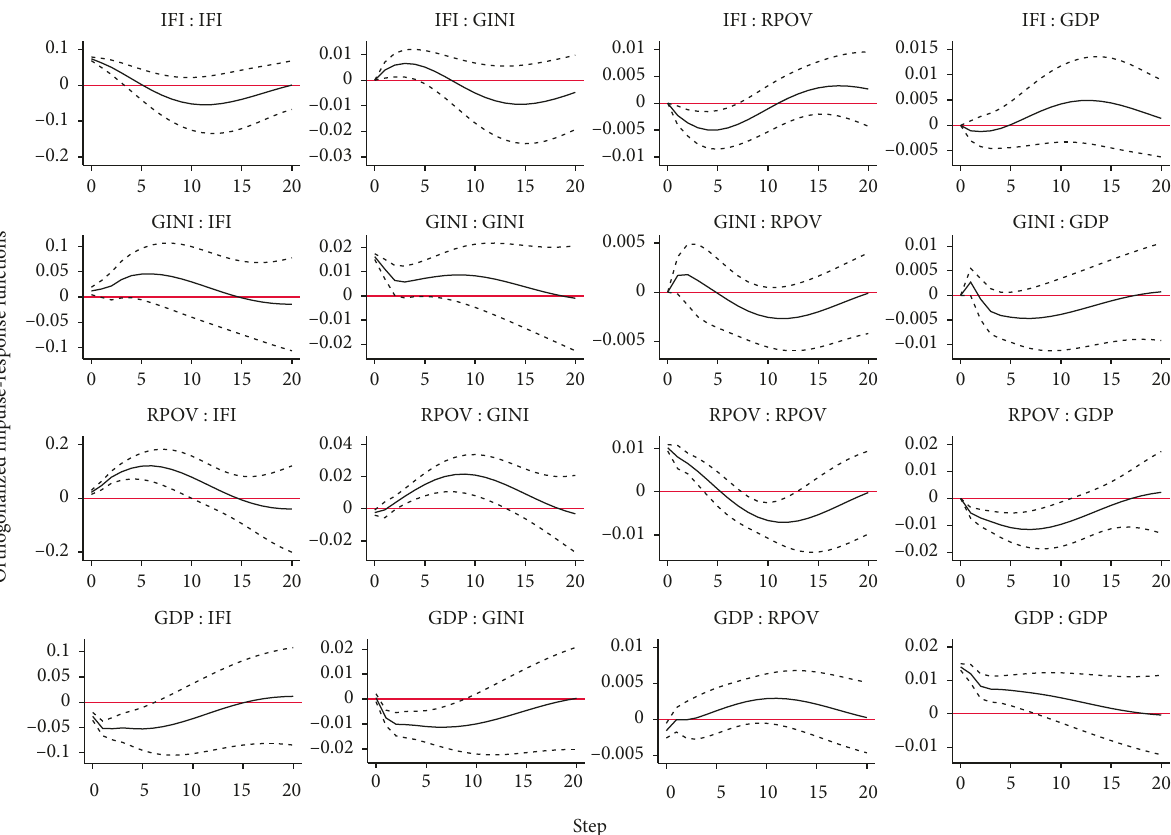
Figure 2: Impulse response function at the national